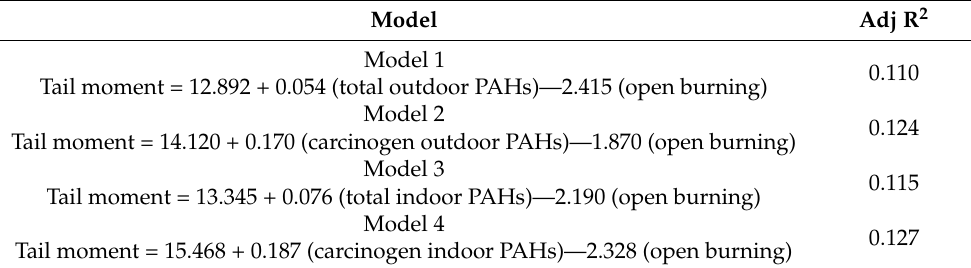
Table 4. Prediction models of the tail moment after controlling all